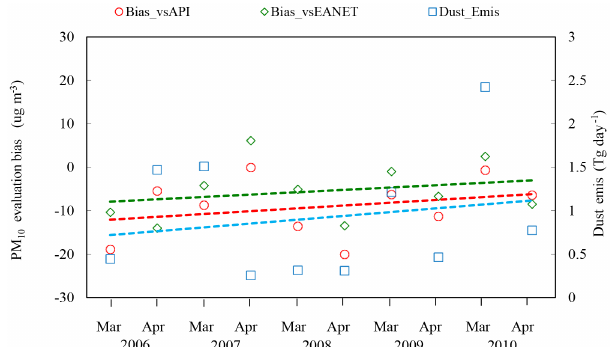
Figure 9. CMAQ predictions of dust emission rate (solid orange rectangles) and simulation bias of PM 10 against observations from API (red circles) and EANET (green diamonds). Dashed lines indi- cate the trends of the